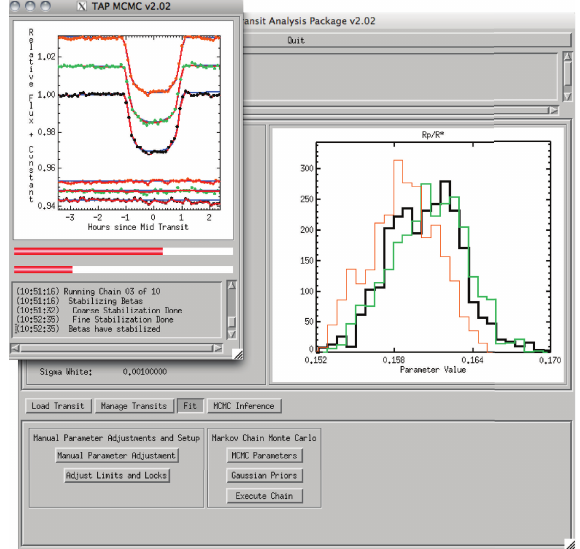
Figure 1: The Transit Analysis Package (TAP) Graphical User Interface while executing a Markov Chain Monte Carlo analysis on three light curves of WASP-10b (Section 3.1). The main background widget freezes during MCMC calculation as a new smaller widget is spawned in the foreground. The MCMC widget provides updates on the status of the analysis process while plotting every tenth x n model state with a blue analytic model and red curve representing the model and red noise. The top and bottom progress bars represent the current chain and overall completeness,